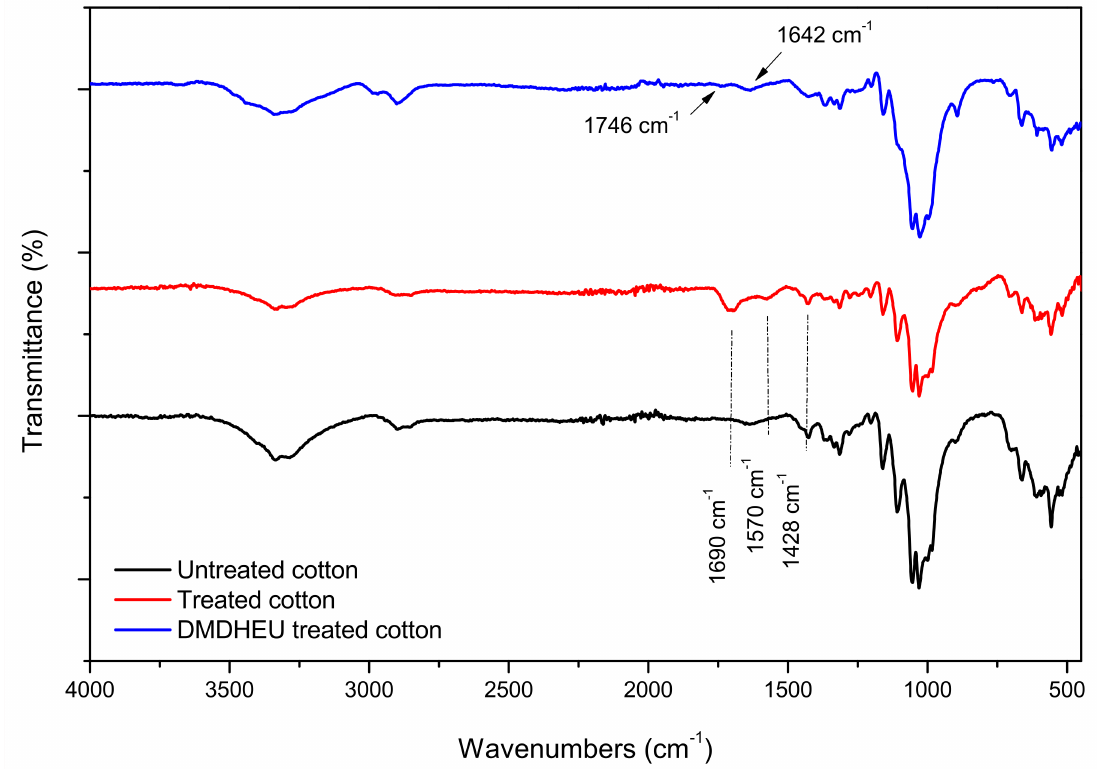
Figure 5. ATR-FTIR spectra of the treated, DMDHEU treated and untreated cotton